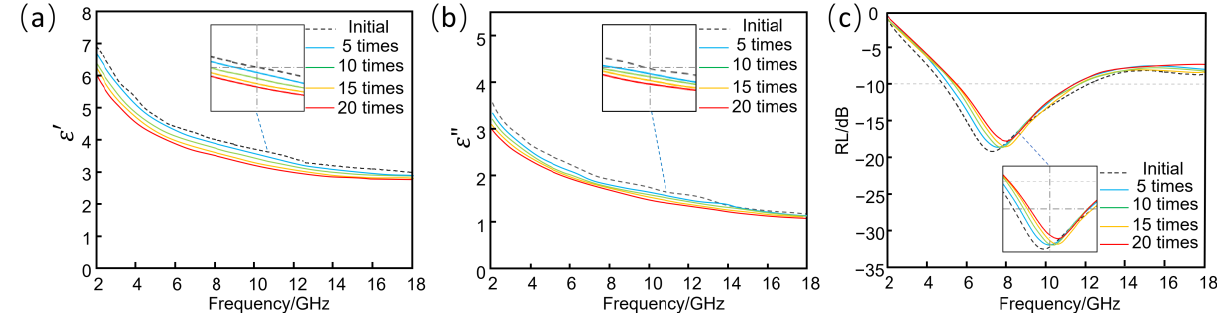
Figure 7. Electromagnetic properties after different treatment times: ( a ) real part of dielectric constant; ( b ) imaginary part of dielectric constant; ( c ) reflection loss.